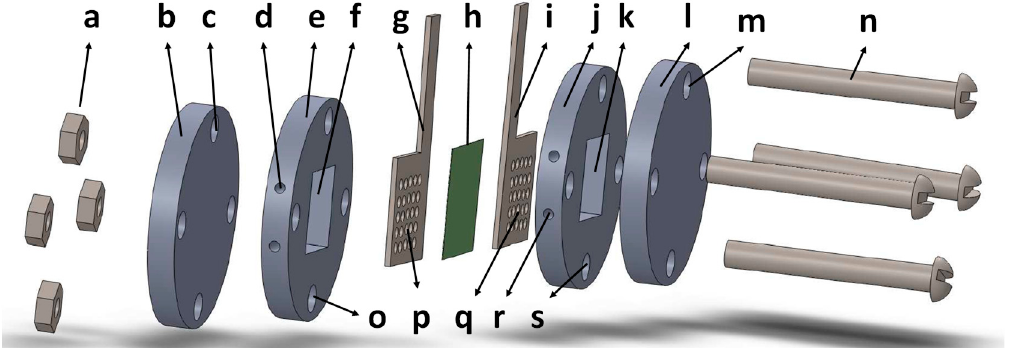
Figure 2. Conventional electrochemical cell of two chambers. a, nuts; b, l, Nylon covers; c, m, o, s, screw holes; d, r, oxidant and reducer agent input and products and excess reagent output, respectively; e, j, structures of the oxidation and reduction chambers; f, k, chamber cavities for oxidation and reduction; g, i, stainless steel electrodes of the electrolyzer cell, and which are both coated with Pt particles for the fuel cell; h, bio-membrane of the agave cuticle; n, screws; p, q, holes within both stainless steel electrodes (g and i) to achieve good contact among the reagent, electrode and membrane. The bio-membrane (Figure 2h, 0.8 mm thick and 4.0 cm 2 large) was installed within the electrolyzer cell between the stainless steel electrodes (Figure 2, represented by g, i) and the chambers were filled with sodium hydroxide (NaOH) solution (Figure 2, denoted by letters f, k). The working temperature was 369 K at atmospheric pressure. On the other hand, in the fuel cell setup the bio-membrane (Figure 2, indicated as h, 0.8 mm thick and 4.0 cm 2 large) was installed between the stainless steel electrodes covered with Pt